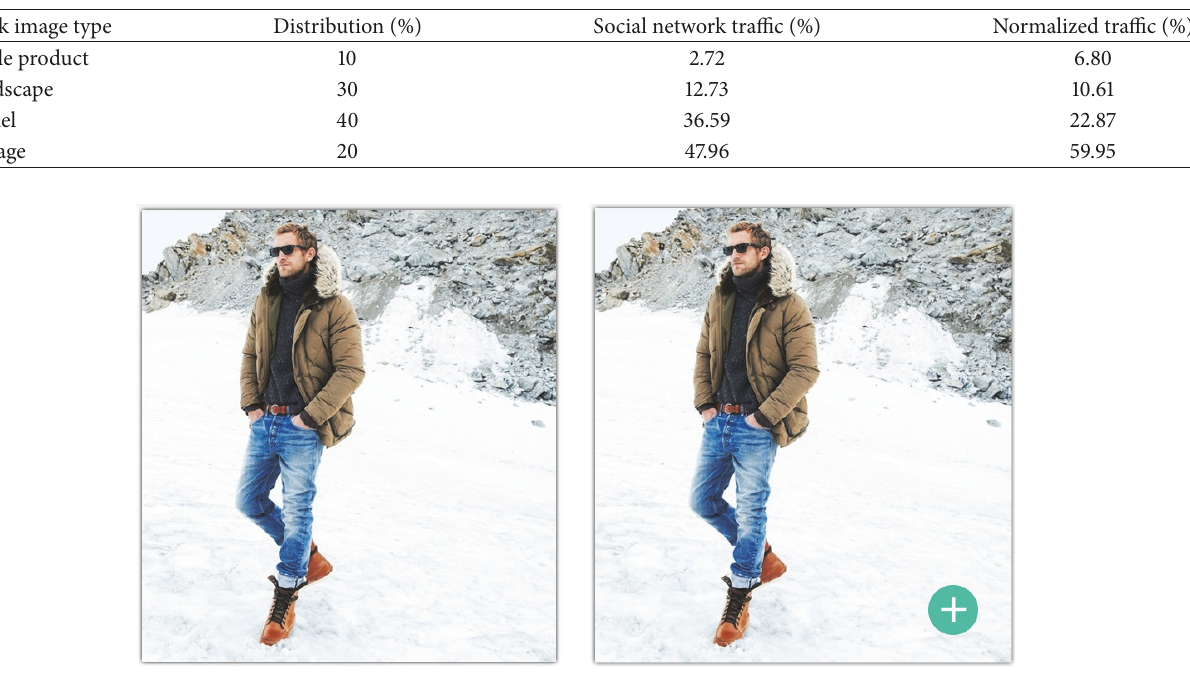
Figure 9: Stamping “Hook” photo. (a) The image a user wants to pair with products and (b) the same image stamped and encoded with an OPCI.